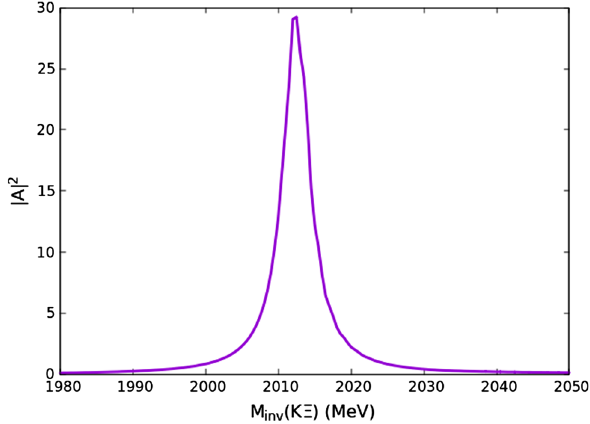
Fig. 6 Plot of the modulus square of the amplitude A of H → ¯ K (cid:3) (see Eq. (11)) as a function of M inv ( ¯ K (cid:3))